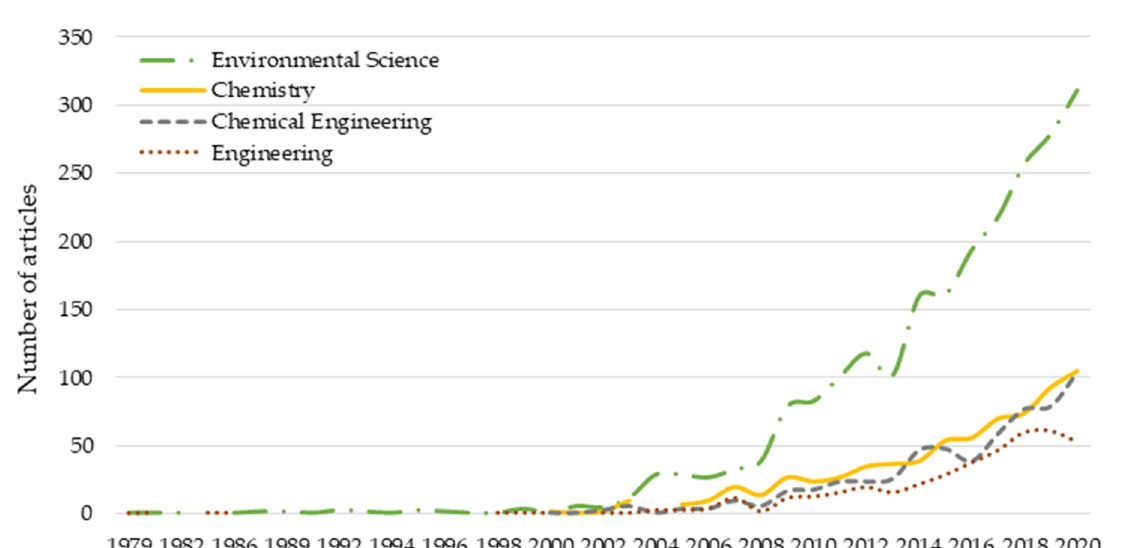
Figure 2. Comparison of growth trends of the main subject areas in the period studied.